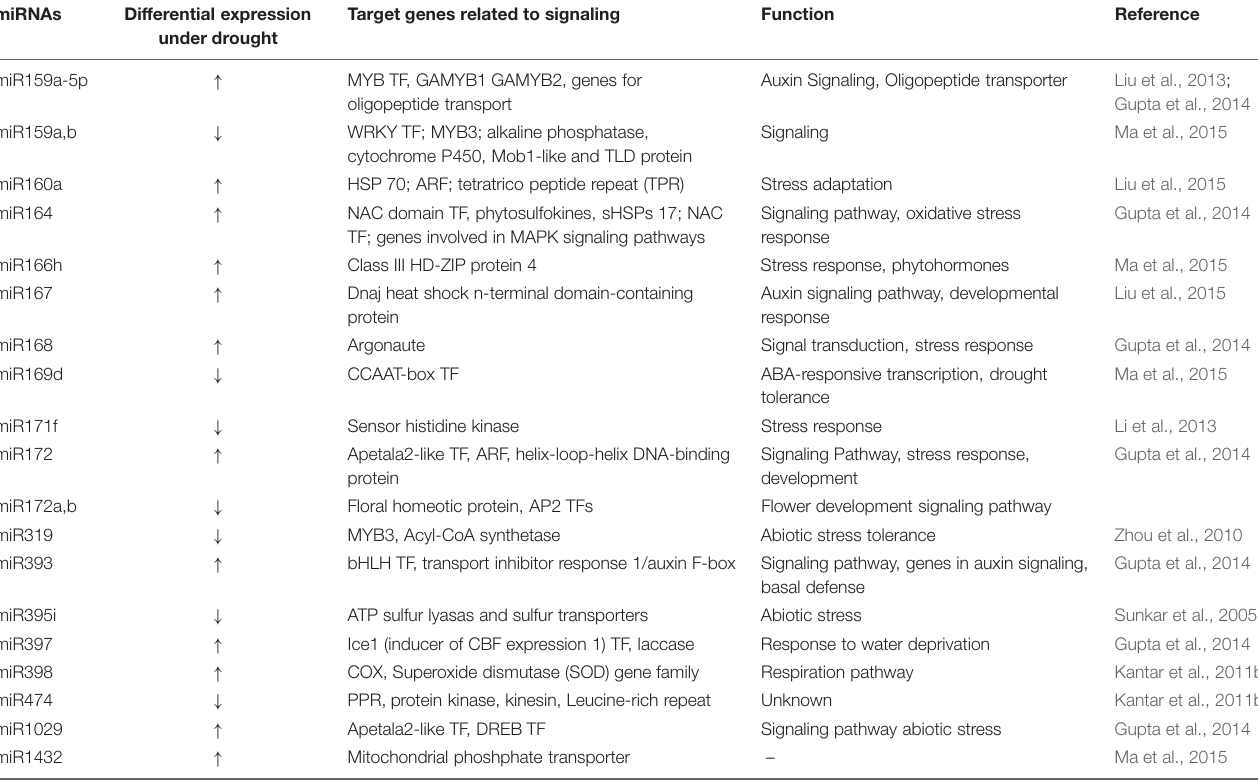
TABLE 4 | Wheat miRNAs involved in drought stress signaling.